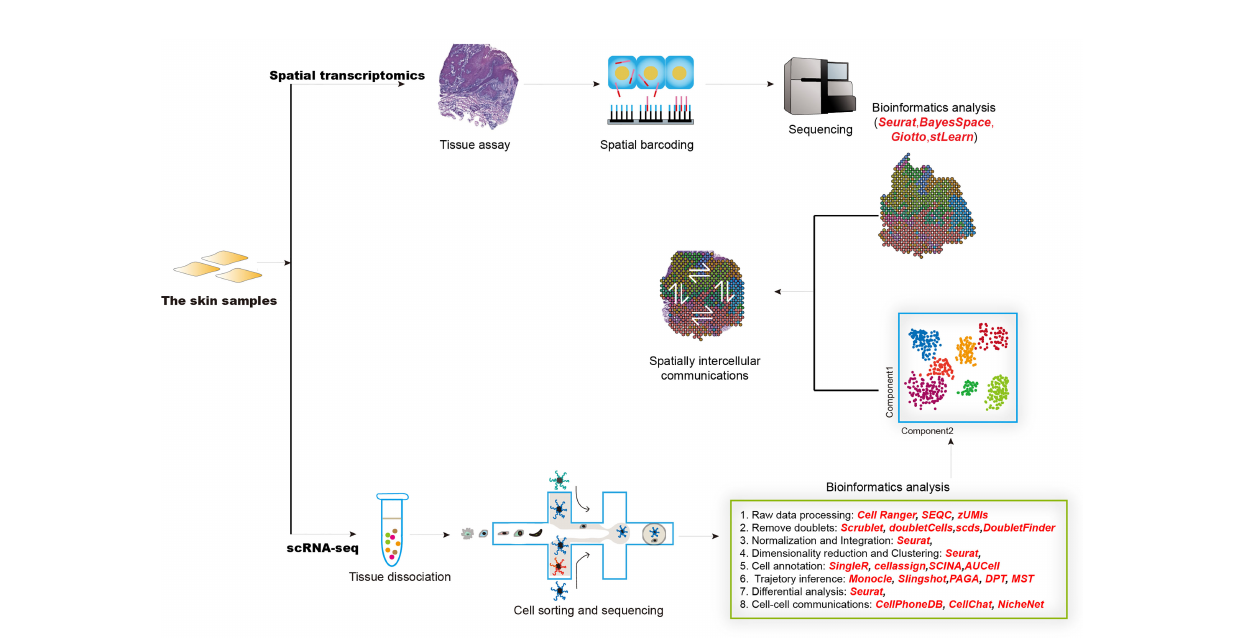
FIGURE 2 | The overall design of experimental and computational analysis for single-cell transcriptomics and spatial transcriptomics studies in in fl ammatory